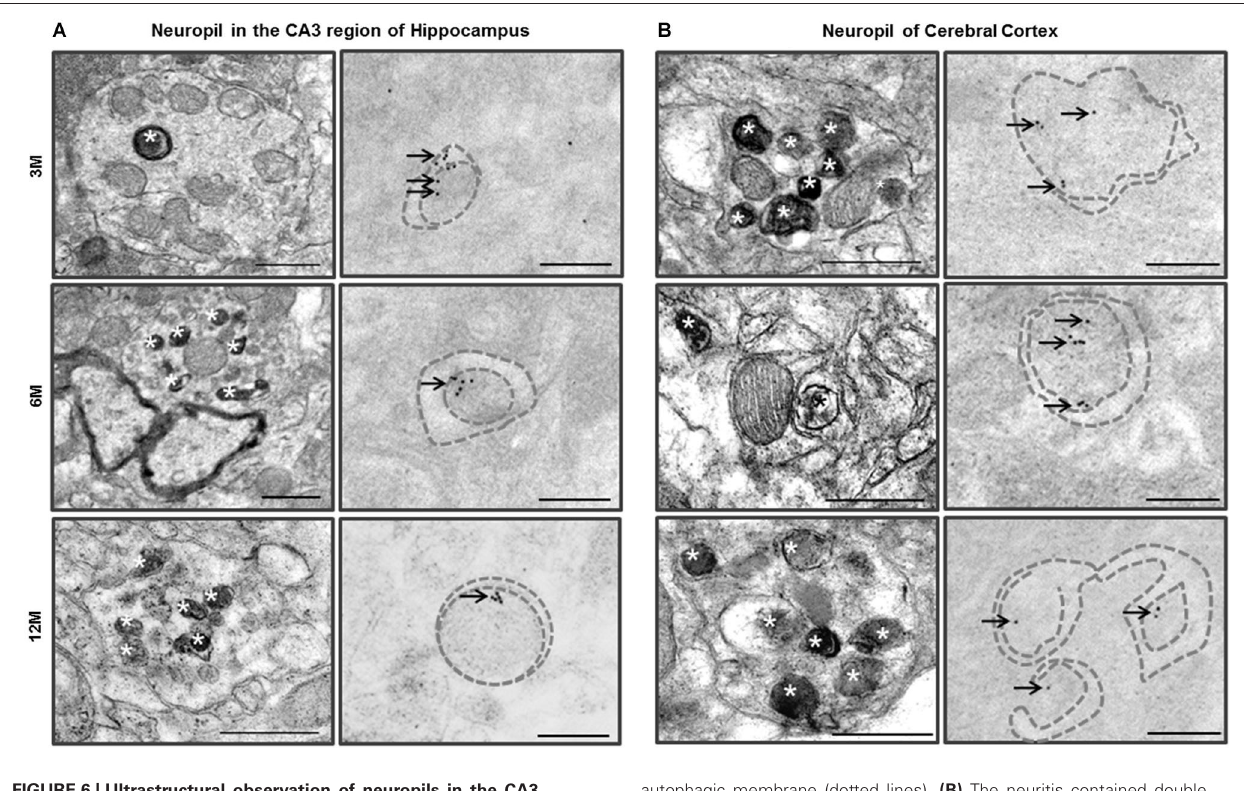
FIGURE 6 | Ultrastructural observation of neuropils in the CA3 region of hippocampus and cerebral cortex of Zürich I mice . (A) The neurites in neuropil of the CA3 region of hippocampus contained many electron dense inclusion bodies (asterisks); these features are indicative of high autophagy activity of neurites. Additionally, LC3B immunogold particles (arrows) localized on the